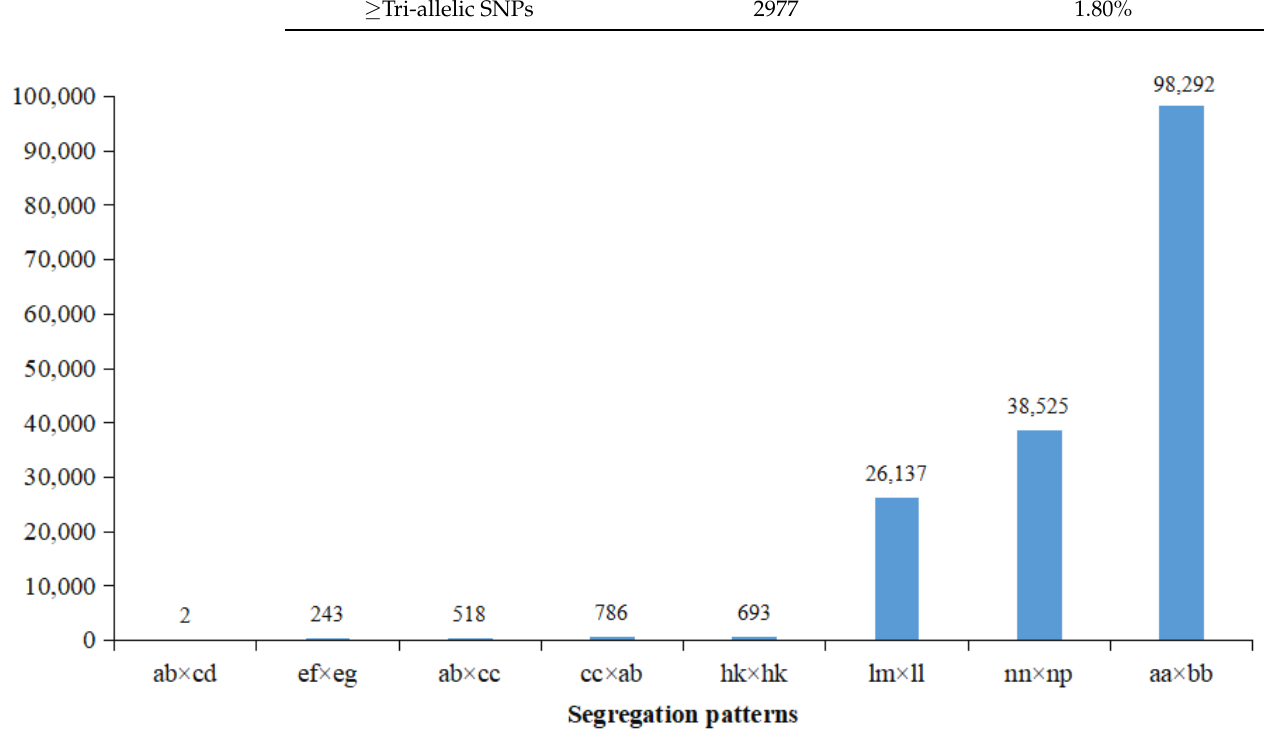
Figure 2. Number of polymorphic SNP markers in each of the eight segregation patterns in Paphiopedilum .